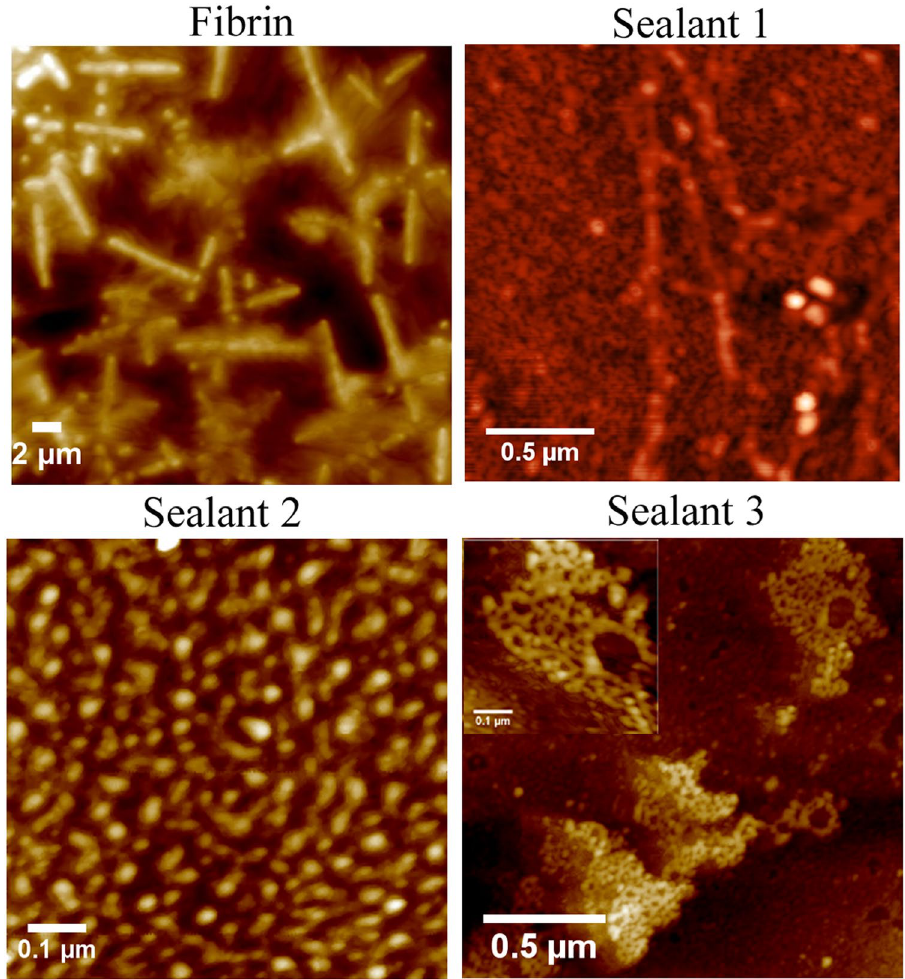
Figure 3. AFM images of the fibrin and sealants 1–3 taken in semi-contact mode. Scale bar of the AFM images of fibrin and sealants 1, 2 and 3 are 2, 0.5, 0.1 and 0.5 µ m,